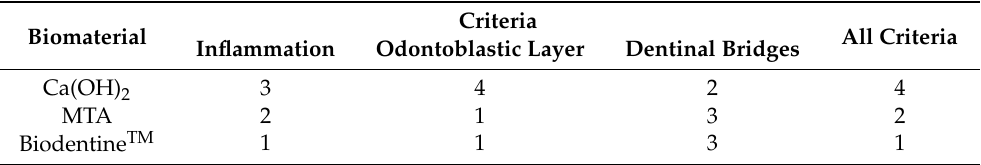
Table 3. Modal values of the different criteria characterizing the histologic features of the three DPC biomaterials, according to the scores (1–4).